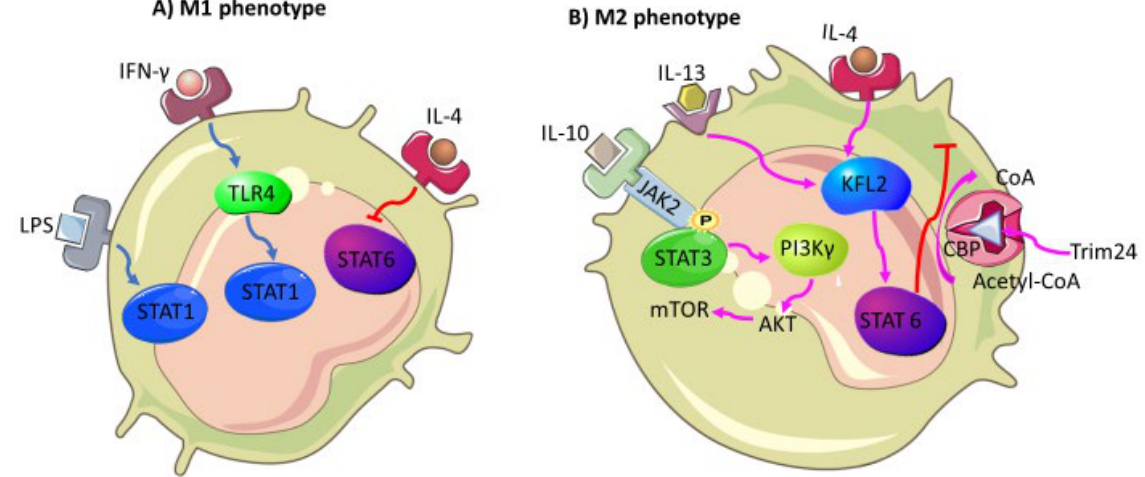
Figure 4. Molecular mechanisms favoring M2 polarization. STAT is one of the key signaling pathways with the prominent immunosuppressive capacity of tumor-associated macrophages. STAT6, in particular, serves as a double agent with its ability to favor cancer progression in collaboration with KFL2 but then again promote anticancer mechanisms via its gene machinery, which goes through acetylation by CBP to halt M2 polarization, a mechanism that can be targeted and manipulated so it can be activate long enough to allow the immune system to clear off cancer cells before they continue to the escape phase of immunoediting.